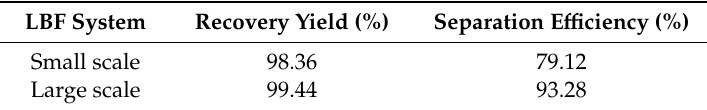
Table 1. Comparison between small- and large-scale LBF systems for the protein extraction of P. tenulla